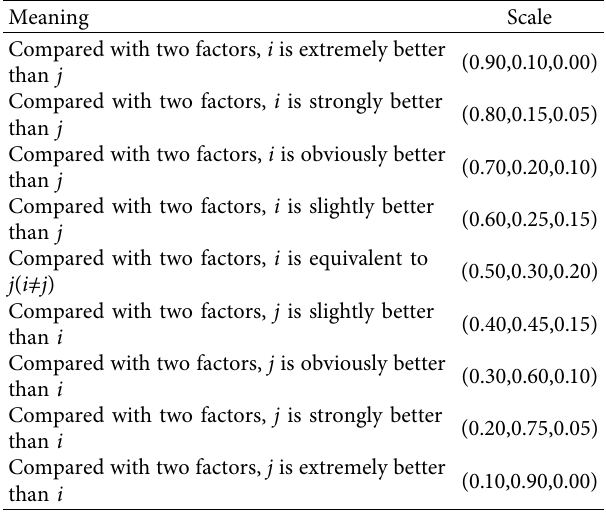
Table 2: IFAHP pairwise comparison scale and meaning. Meaning Scale Compared with two factors, i is extremely better than j